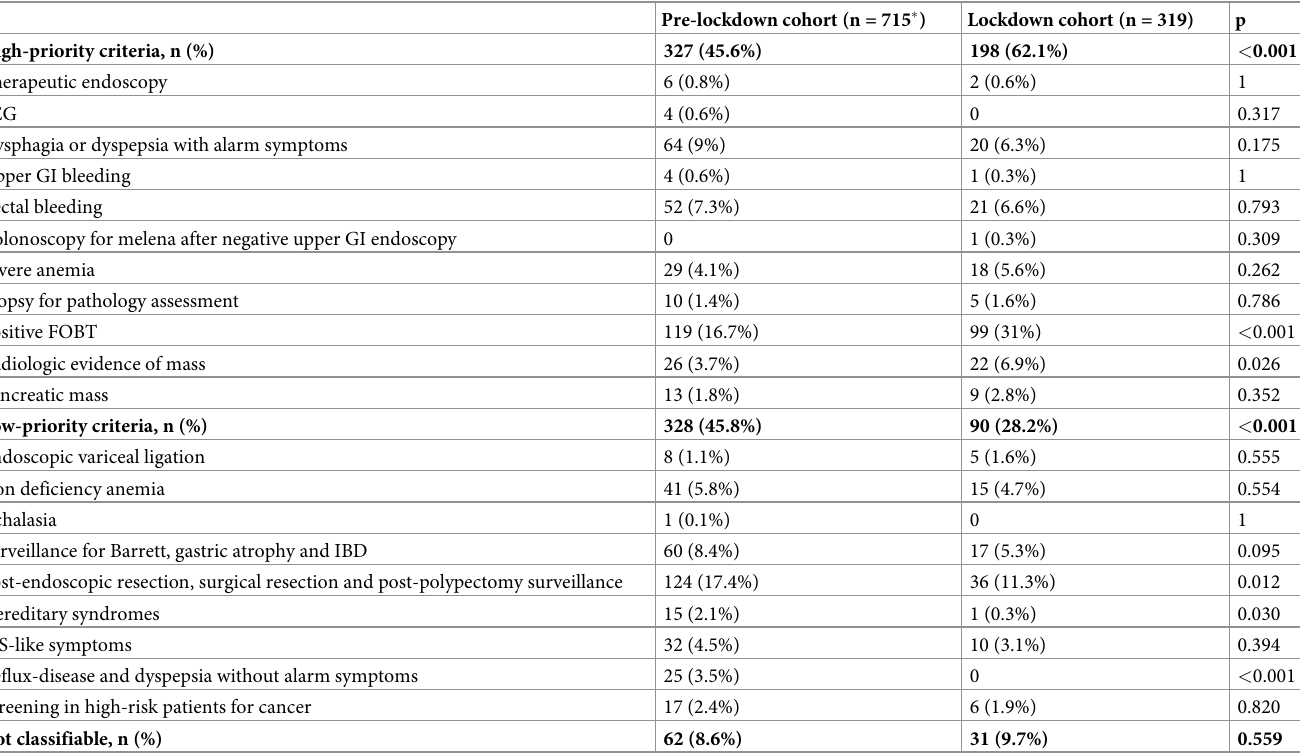
Table 1. Clinical indications categorized according to the ESGE criteria of outpatient endoscopy procedures in the pre-lockdown and lockdown cohorts.